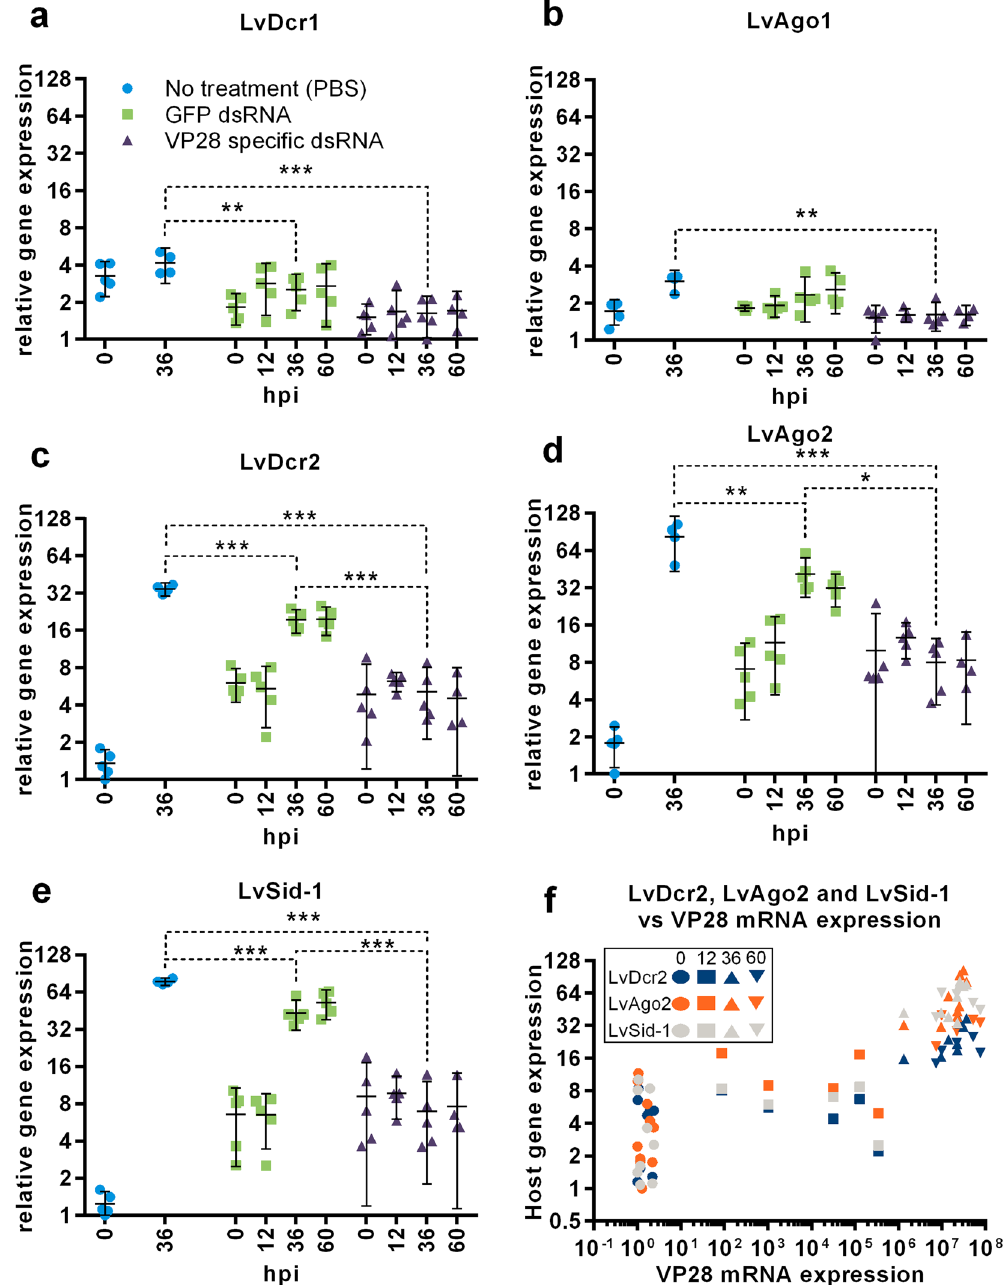
Figure 7. During the first 60 hours of WSSV infection, relative gene expression on a panel of host genes associated with small RNA silencing was carried out by RT-qPCR assays ( a – e ). Relative gene expression was measured through fold variation from the lowest obtained normalized expression value observed in all samples. One-way ANOVA with Tukey’s multiple comparisons test was performed individually for each gene comparing groups at 36 hpi. Significant variation at α = 0.05 is indicated and error bars indicate the 95% CI around the mean. To investigate LvDcr2, LvAgo2 and LvSid-1 host genes’ dependency to WSSV virus load and time since infection, all individual normalized expression values obtained for these genes in the no treatment (PBS) and GFP dsRNA treatment groups was plotted against VP28 normalized expression level registered in the respective samples ( f